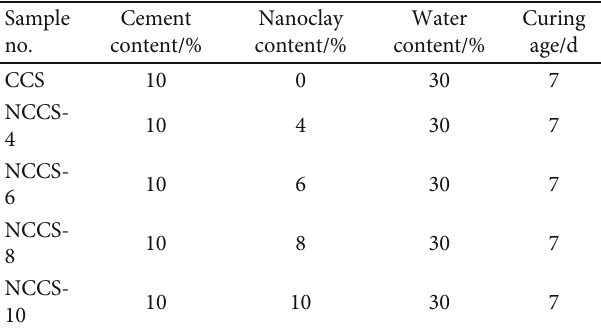
Table 4: Experimental design